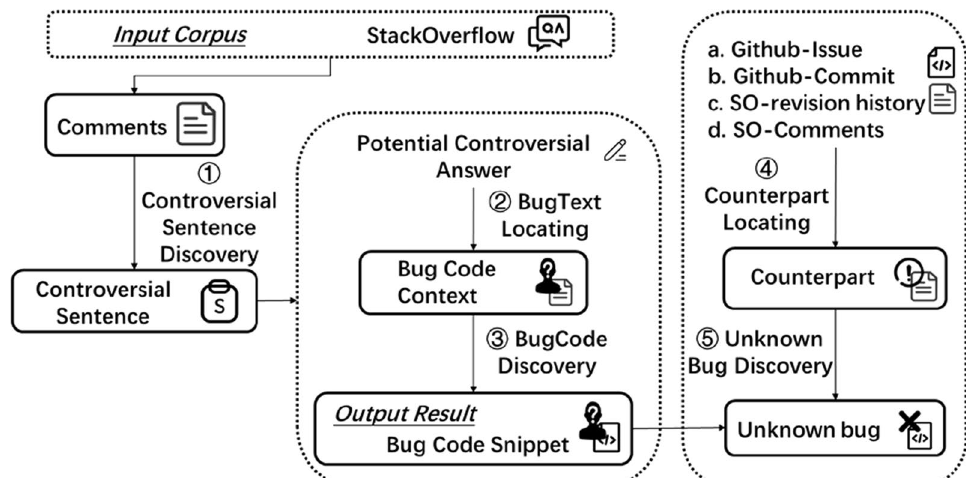
Fig. 2 The workflow of our discovery